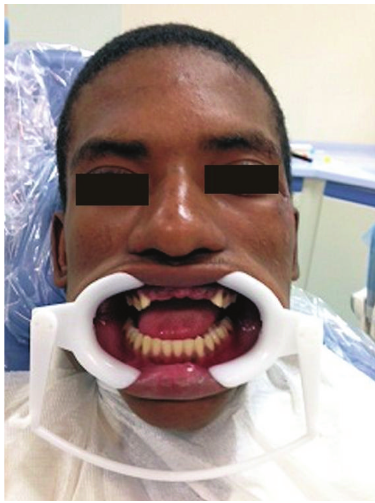
Figure 4: Photograph exhibiting prepared abutment teeth.